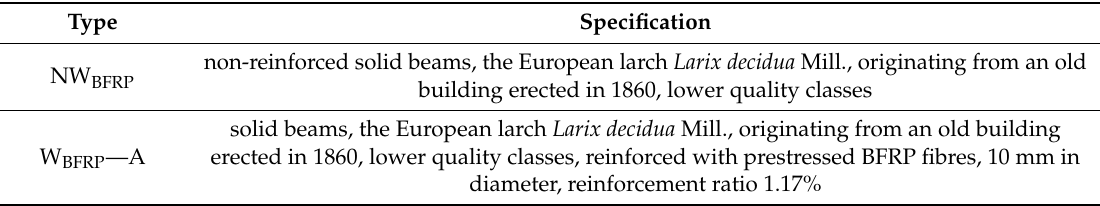
Table 2. Specifications of the types of old beams of the European larch, lower quality class, reinforced with prestressed BFRP fibres.